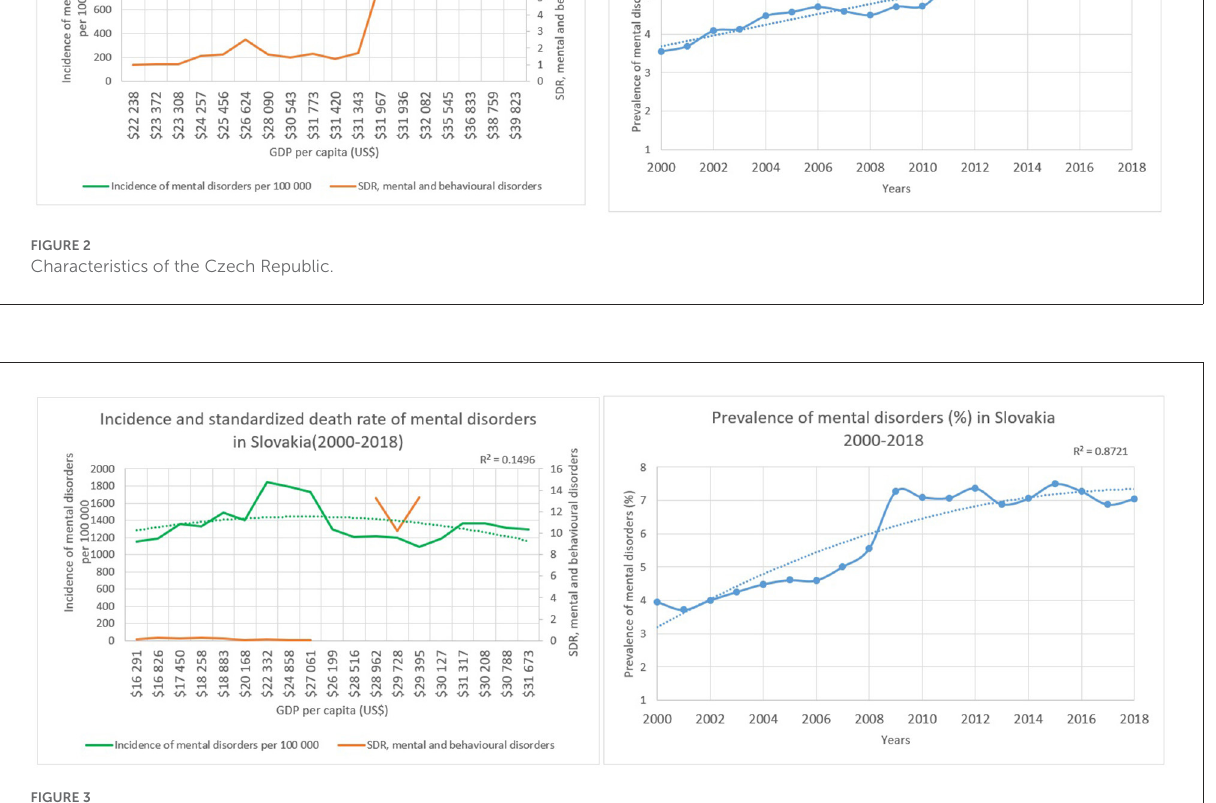
FIGURE3 Characteristics of